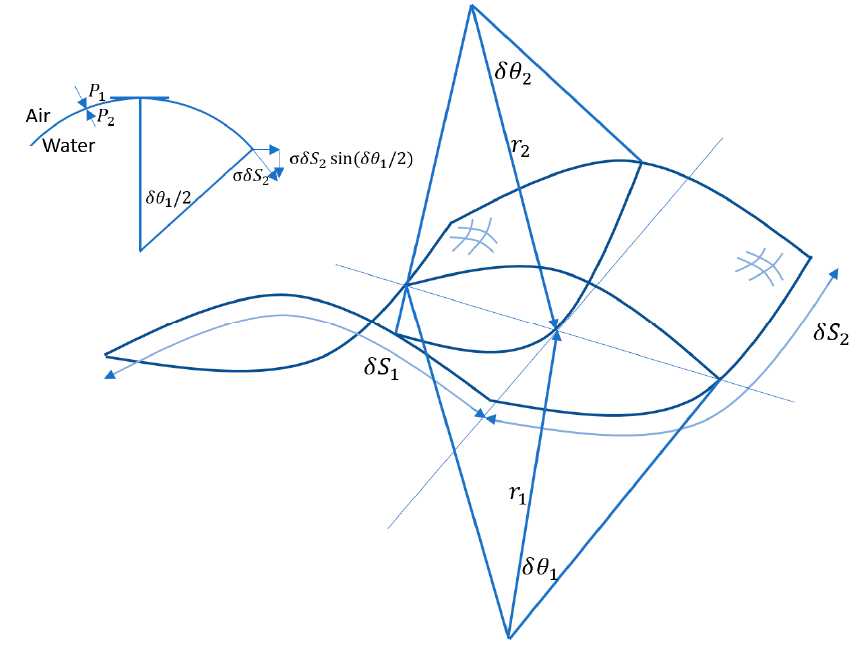
Figure 5. An anticlastic (doubly curved) liquid surface, modified from [72]. Small angle approximation for δθ 1 and δθ 2 leads to Equation Cancellation of 𝛿𝑆 (cid:2869) 𝛿𝑆 (cid:2870) simplifies Equation (7) to Laplace’s equation for pressure across an anticlastic surface, provided in Equation (8).